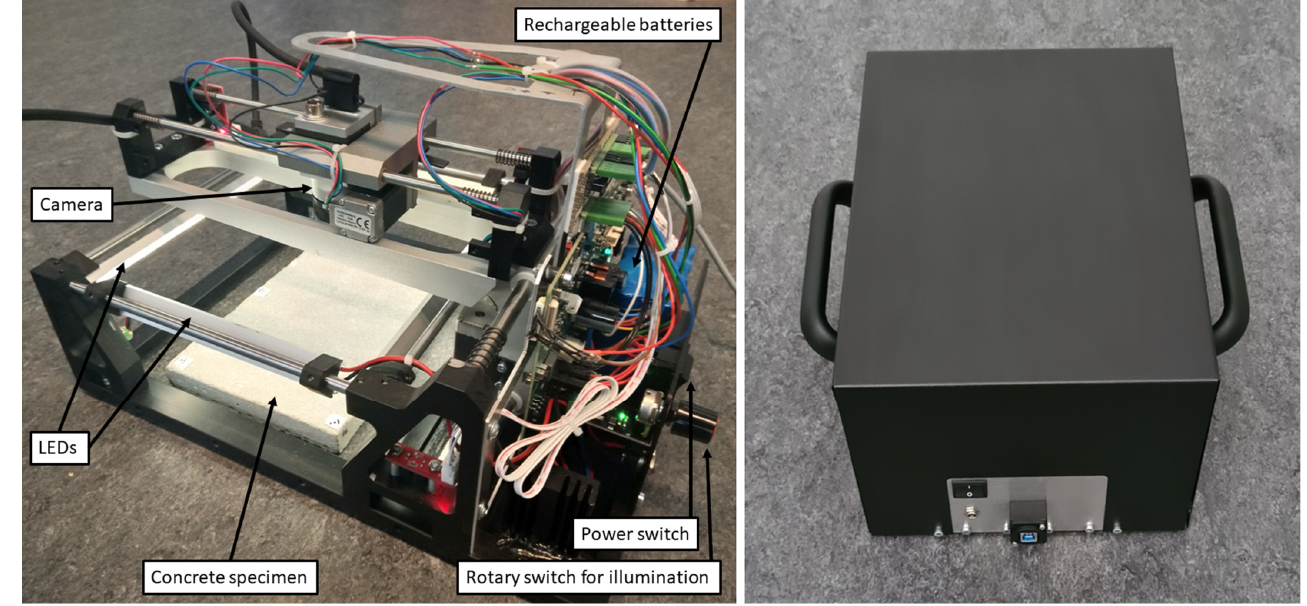
Figure 2. The measurement system—to the left the hardware assembly and to the right the casing.